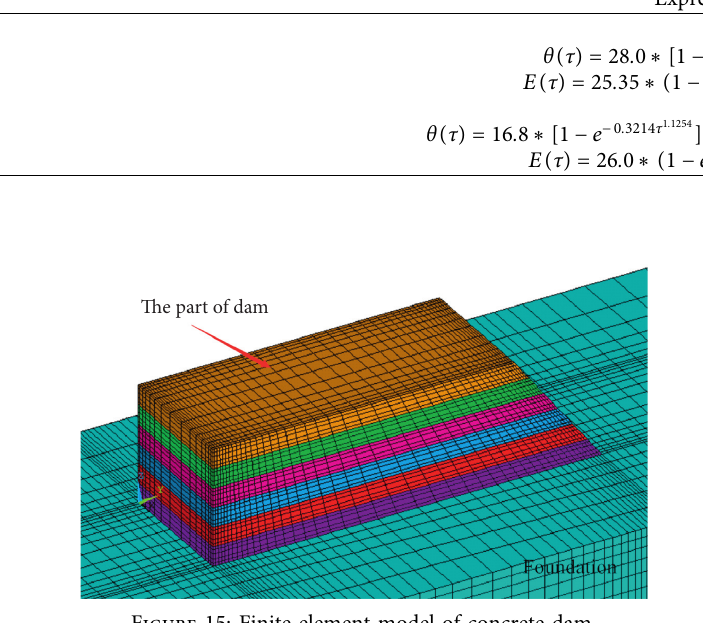
Figure 14: Stress duration curve of key points P1 and P2 of sluice floor. Table 5: Adiabatic temperature rise and elastic modulus expression of concrete gravity dam. Concrete type C20